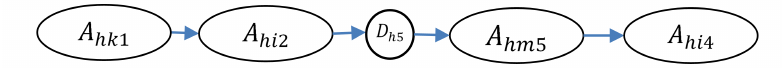
Figure 11. Last part of the operation network after the second interruption and the second conversion